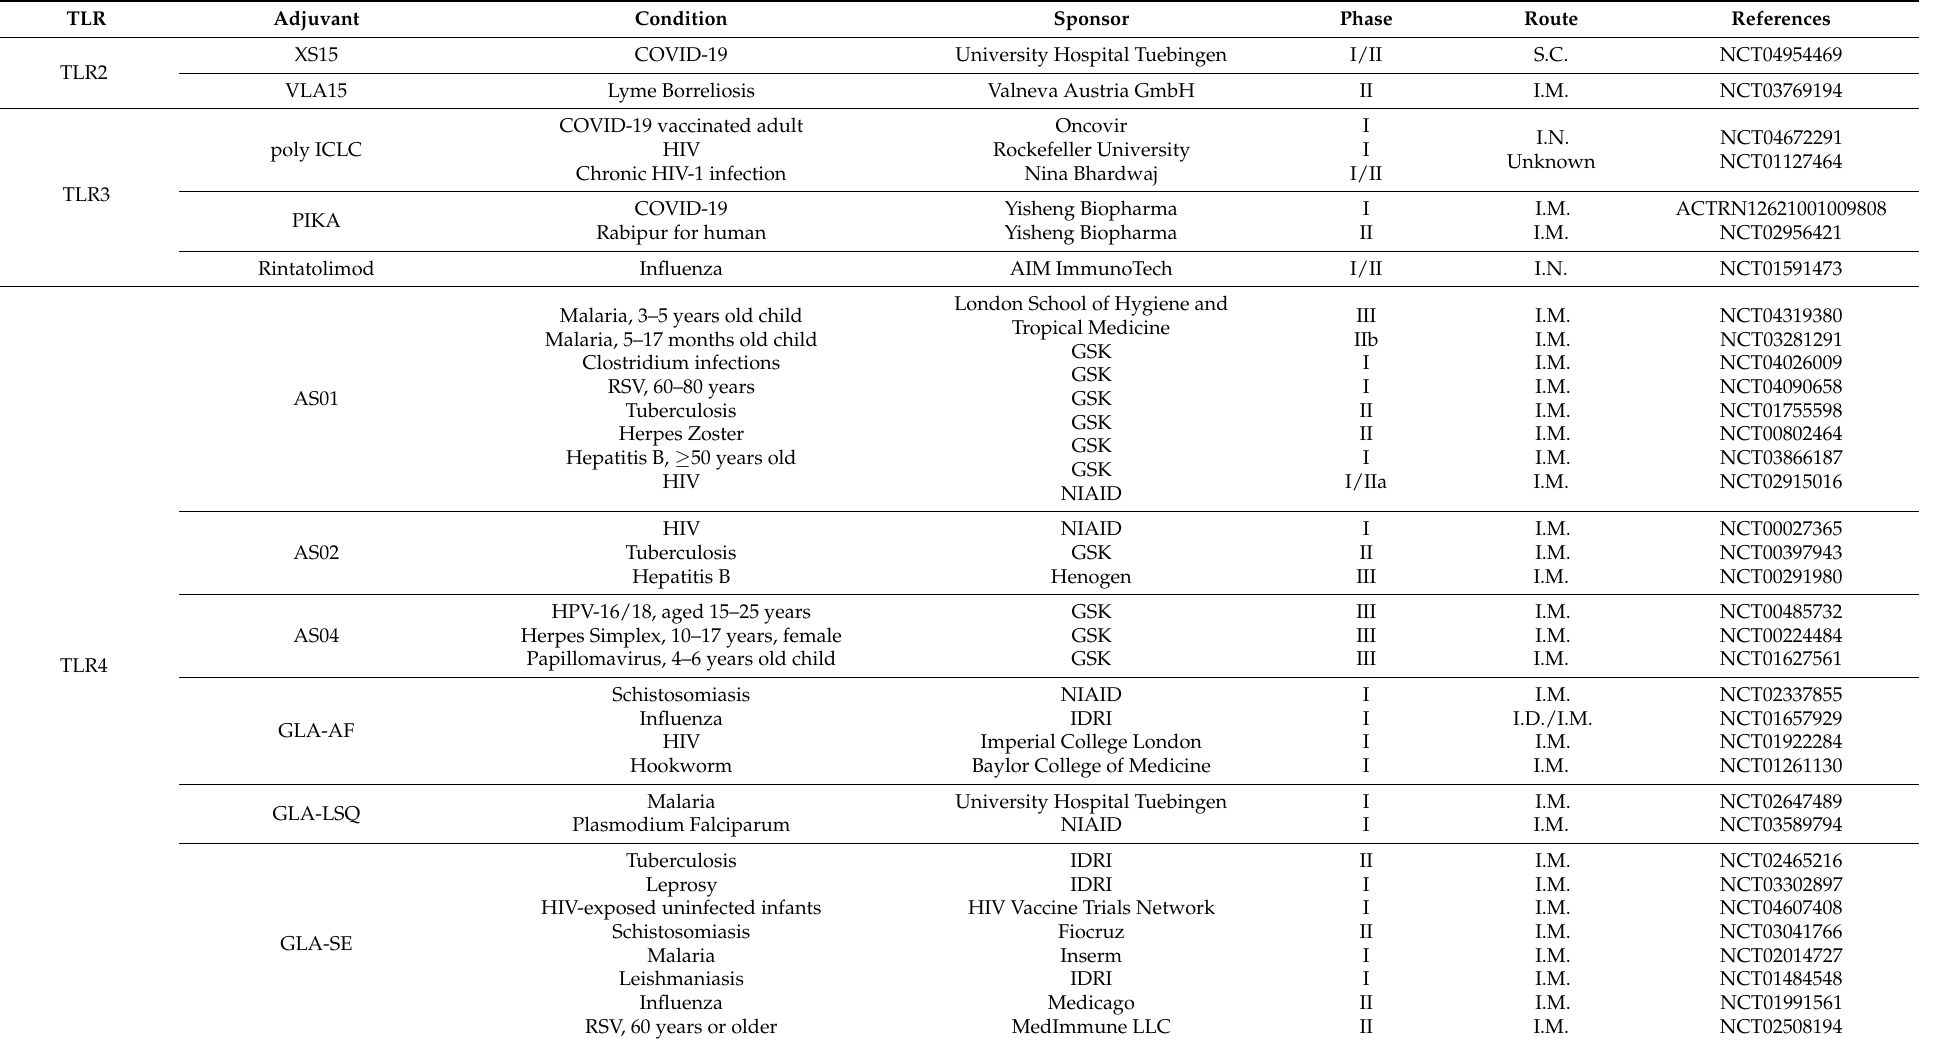
Table 1. TLR adjuvants in clinical